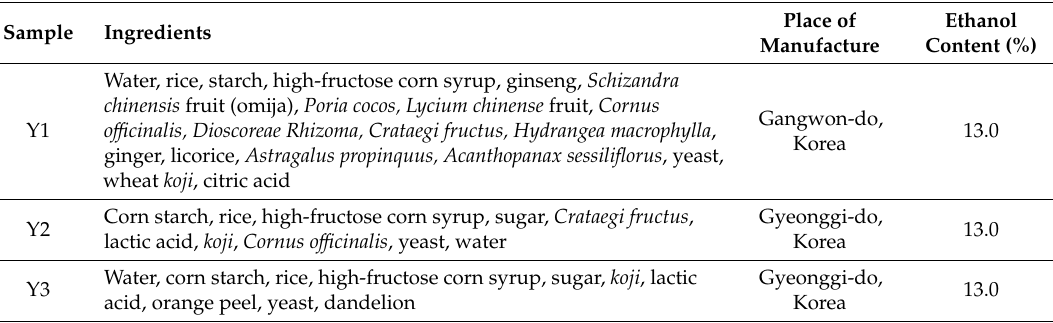
Table 1. Information for the yakju samples 1